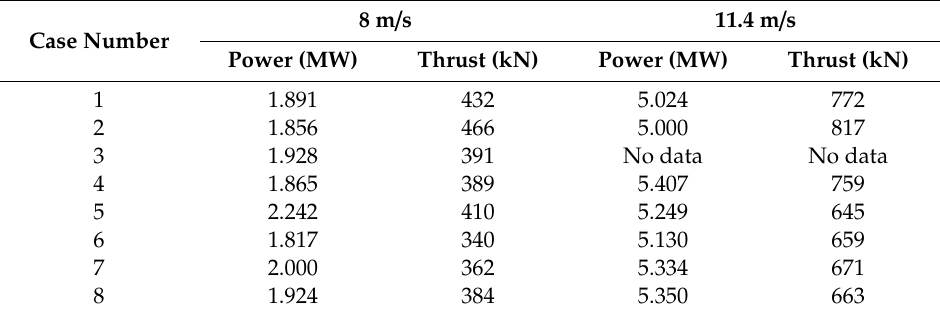
Table 6. Comparison of the power and the thrust with di ff erent